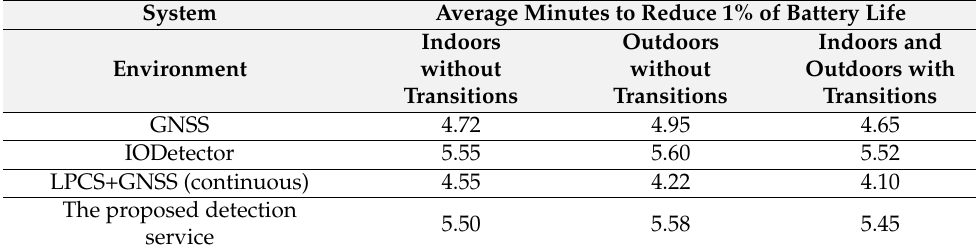
Table 2. Battery power consumption for different I/O detection